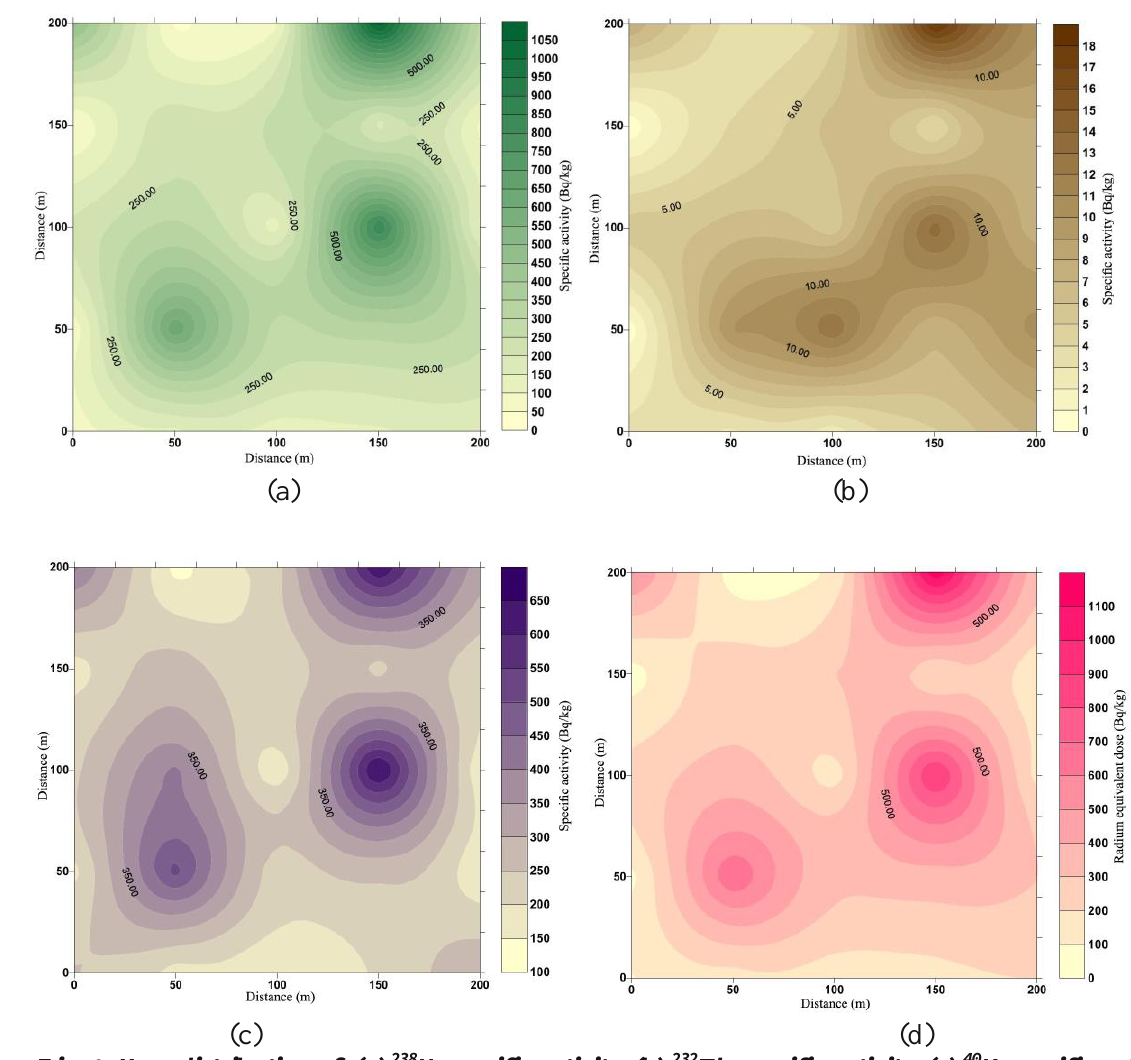
Fig. 1: Map distribution of, (a) 238 U specific activity, (b) 232 Th specific activity, (c) 40 K specific activity, (d) Radium equivalent activity Ra eq